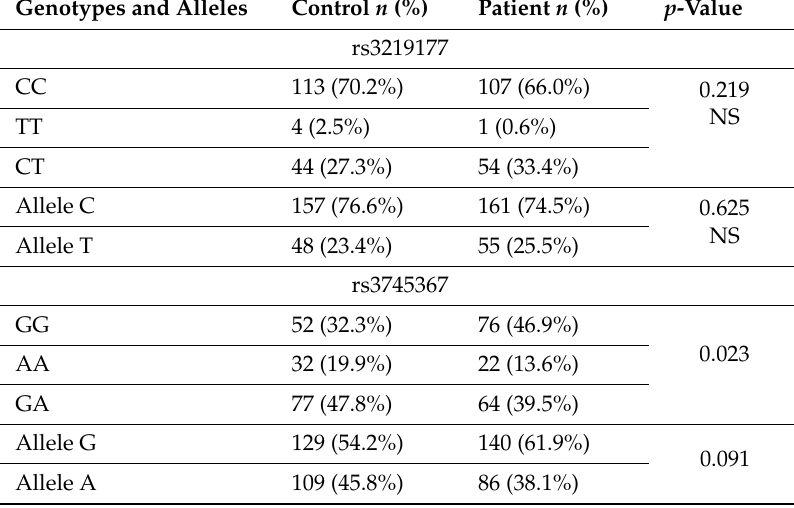
Table 3. Genotype and allele frequencies of rs3219177 and rs3745367 of RETN gene in atopic dermatitis (AD) subjects and